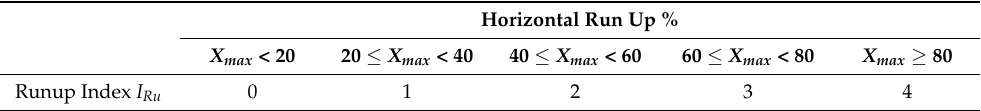
Table 1. Classification of the run-up according to the percentage of beach affected by the wave run-up.